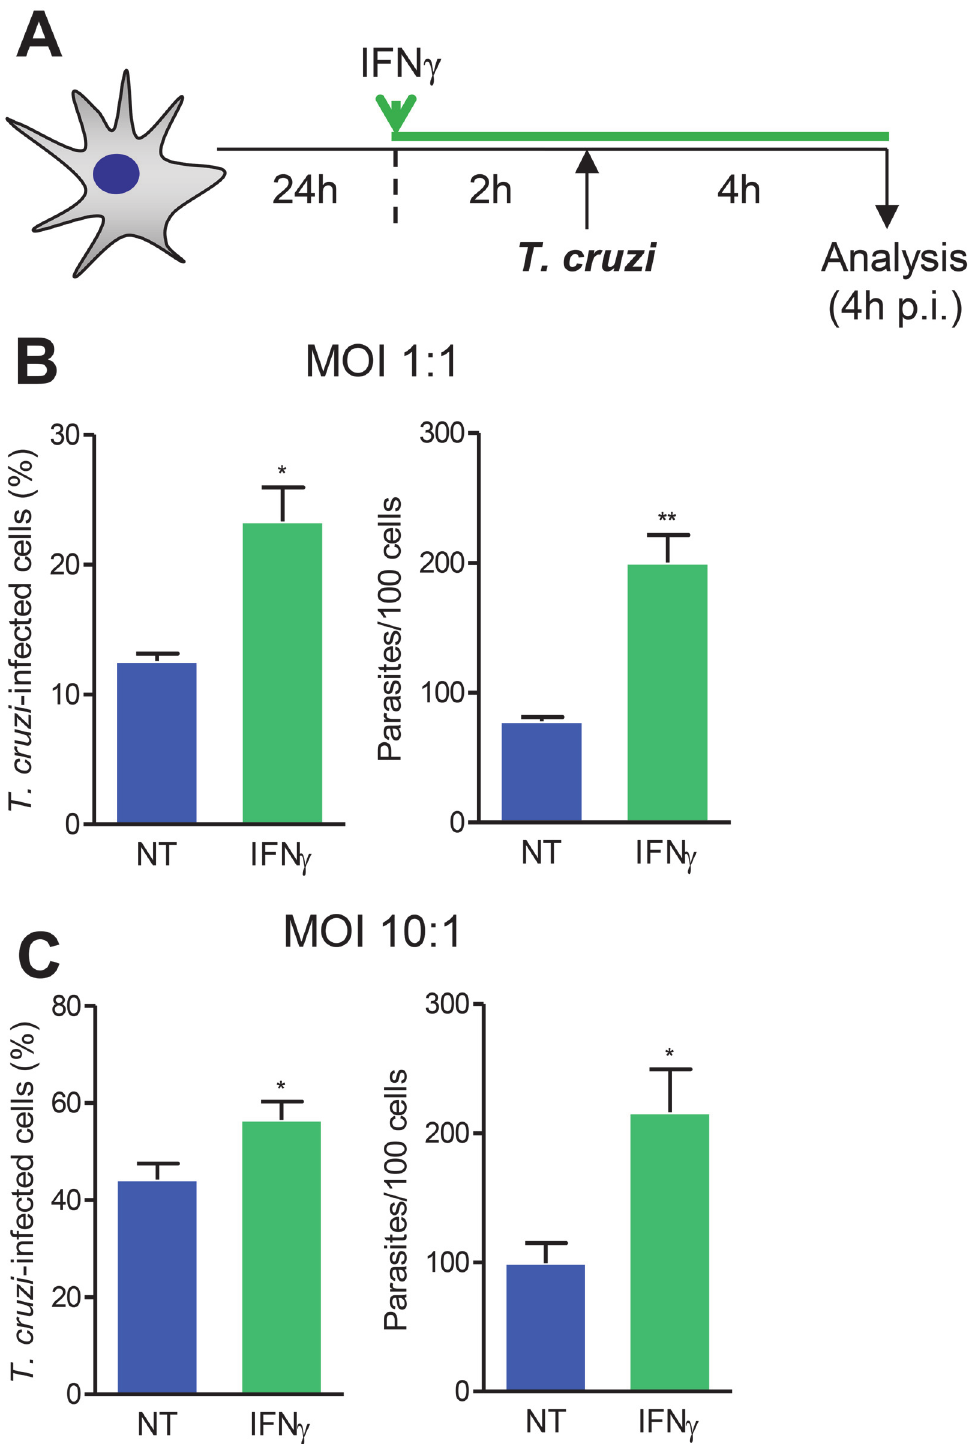
Fig 3. Pretreatment with IFN γ promotes astrocytes infection by T. cruzi . (A) Experimental scheme showing that primary astrocyte cell cultures were pretreated with IFN γ (10 ng/mL) for 2 hours and subsequently infected using MOI 1:1 or 10:1 and analyzed 4 hours post-infection (p.i.). (B) and (C) show the frequencies of T. cruzi -infected cells and the number of parasites per cells, when initial infection MOI was 1:1 or 10:1, respectively. Data are presented as mean ± SEM of triplicates. * , p < 0.05 and ** , p < 0.01 comparing not-treated (NT) with IFN γ pretreated astrocytes in each studied MOI.